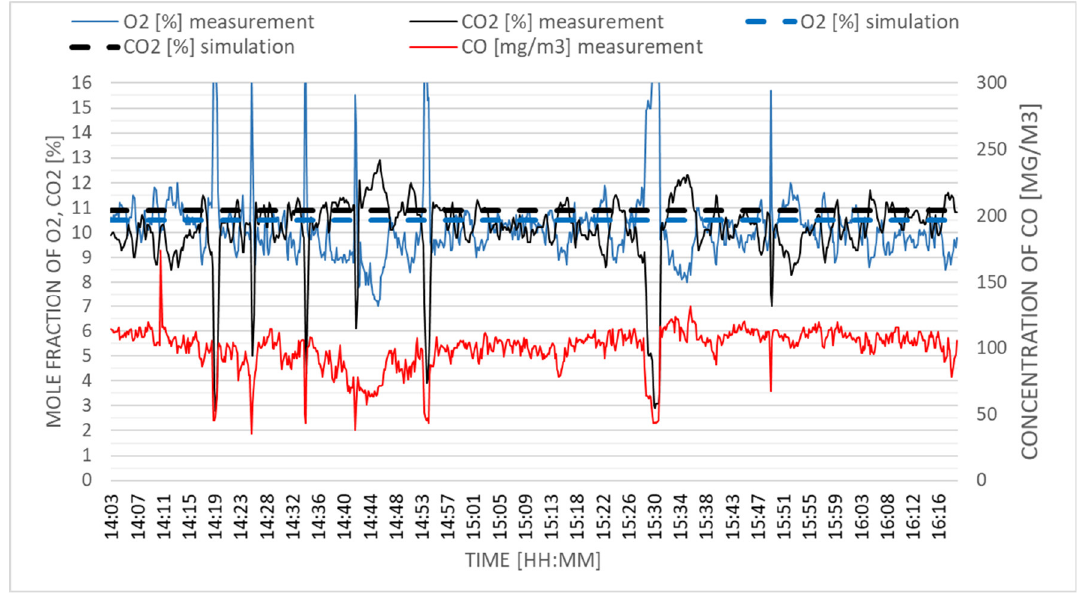
Figure 13. Measured values of gaseous combustion products emission CO, CO 2, and O 2.